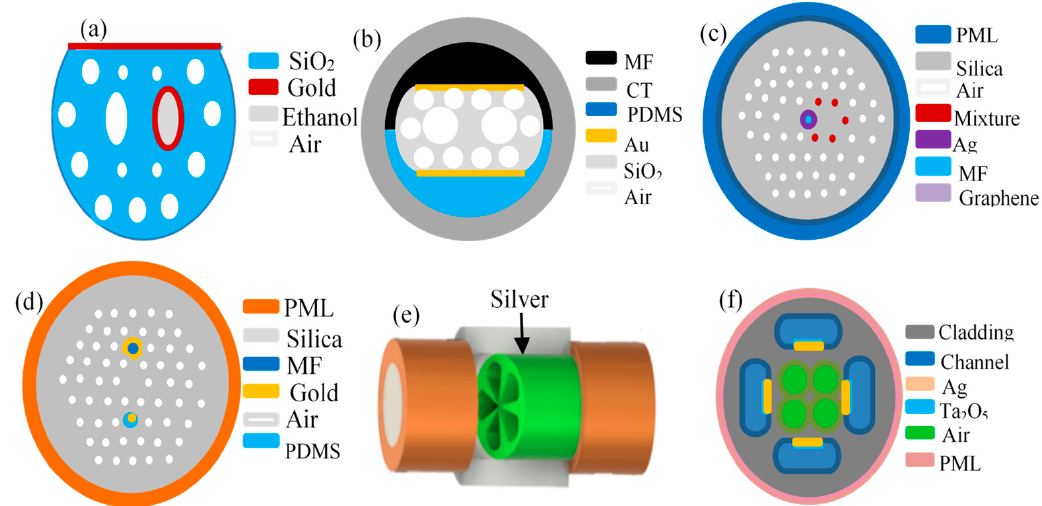
Figure 5. Structure of photonic crystal fiber. ( a ) Single D-shaped structure [49]; ( b ) Double D-shaped [55]; ( c ) double core-shaped structure [57]; ( d ) dual-polarized modes [58]; ( e ) MMF-MOF-MMF structure [59]; ( f ) Large-small hole filling structure [60]. CT, Capillary tube; PML, Perfect match layer.